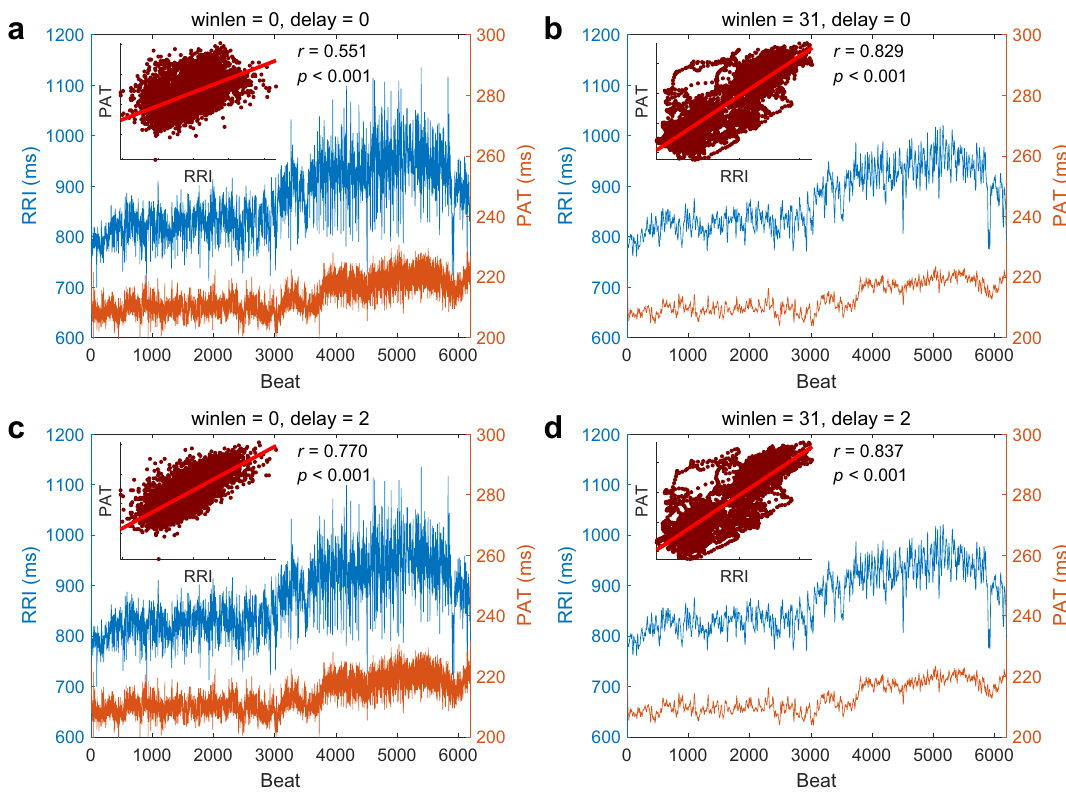
Figure 2. A typical example of RRI and PAT series from one subject in the natural state. winlen, the window length of the Savitzky-Golay filter (if winlen = 0, no smoothing). delay, the delayed beats of RRI series. r, the correlation coefficient. Window length (beat)